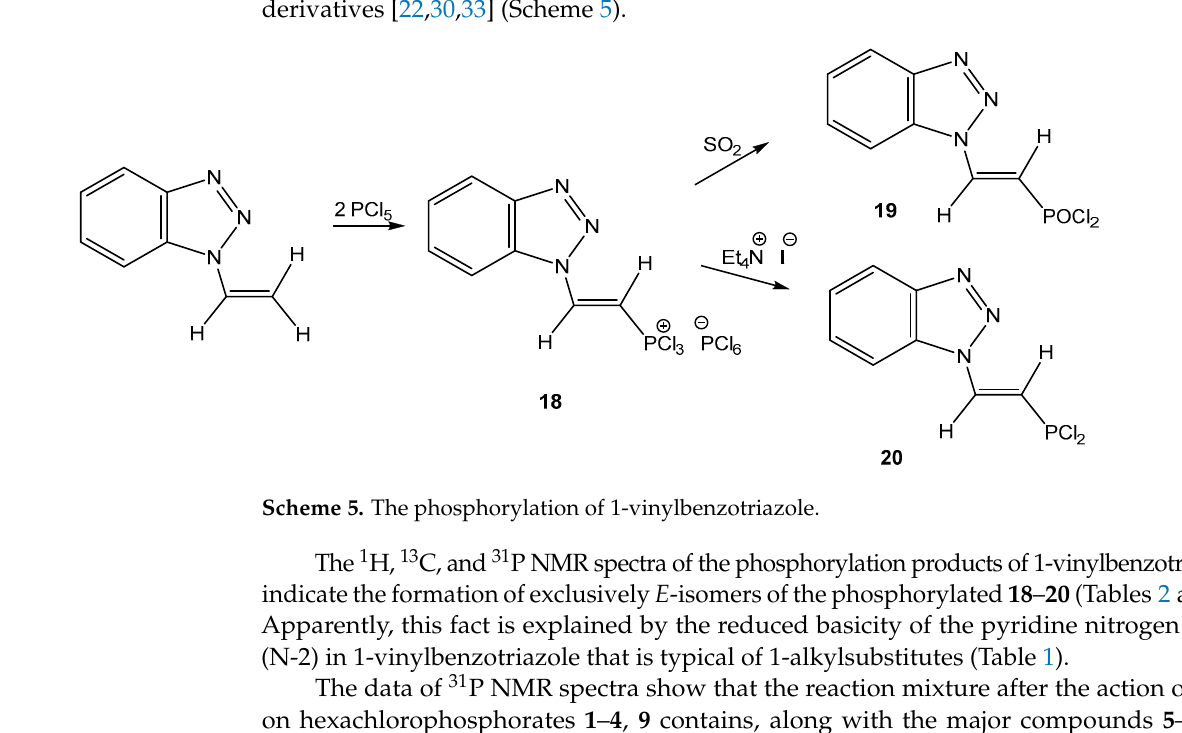
Table 5. 31 P NMR chemical shifts ( δ , ppm) and coupling constants ( J , Hz) of hydrochlorated products of azolylphosphonic dichloroanhydrides ( 21 – 25